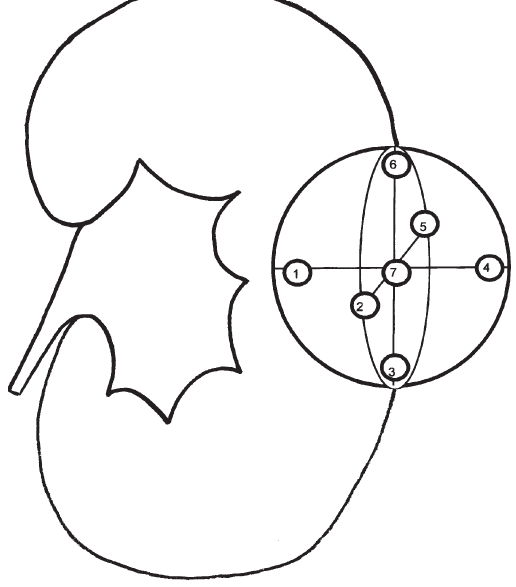
Fig. 1. Tissue acquisition from seven different locations in renal